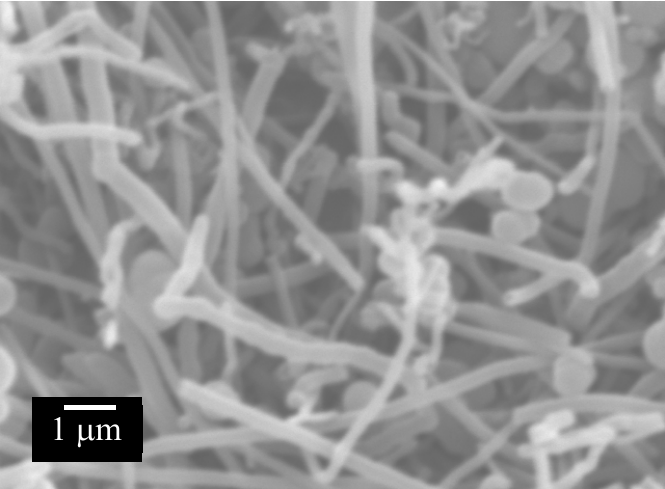
Figure 2: SEM images of the CNFs used in this study.